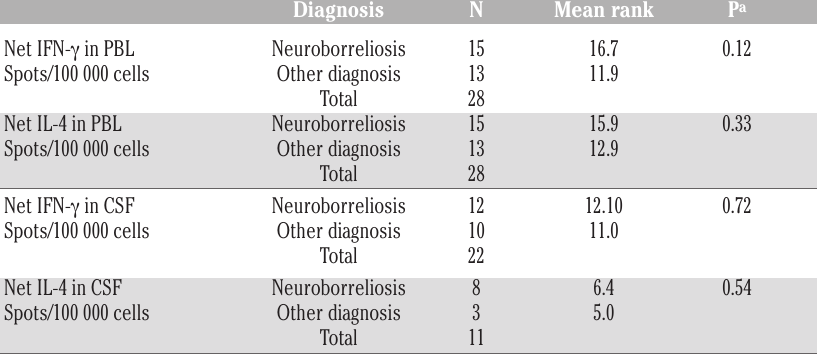
Table 2. Net secretion of IFN- γ and IL-4 spots in patients with possible neuroborreliosis and patients with other